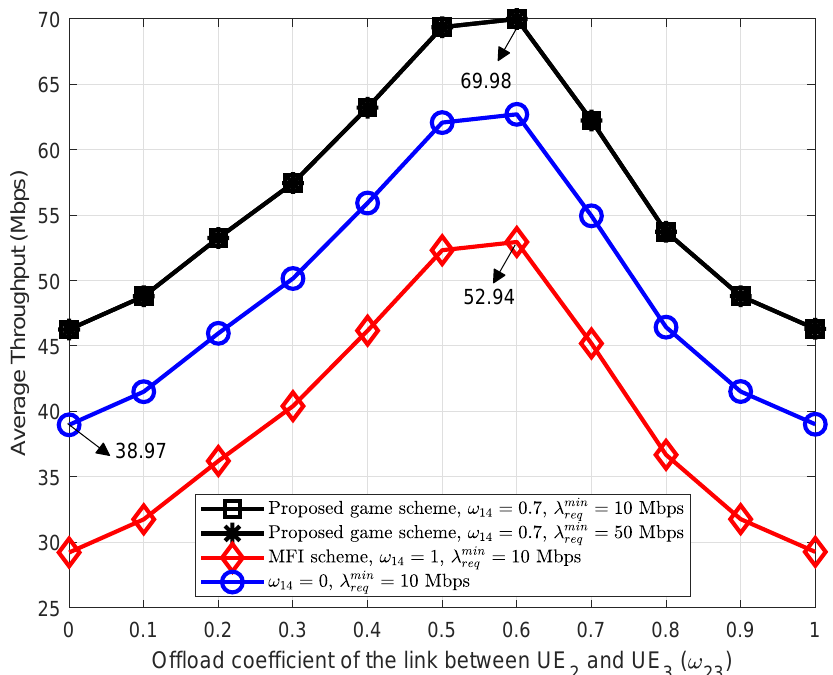
Figure 7. The average throughput according to offload coefficient pairs of the link between UE 2 –UE 3 ( ω 23 ) and the link UE 1 –UE 4 ( ω 14 ) when the minimum required data rate is 10 Mbps and 50 Mbps, respectively, and e hv mean = 15 packets.